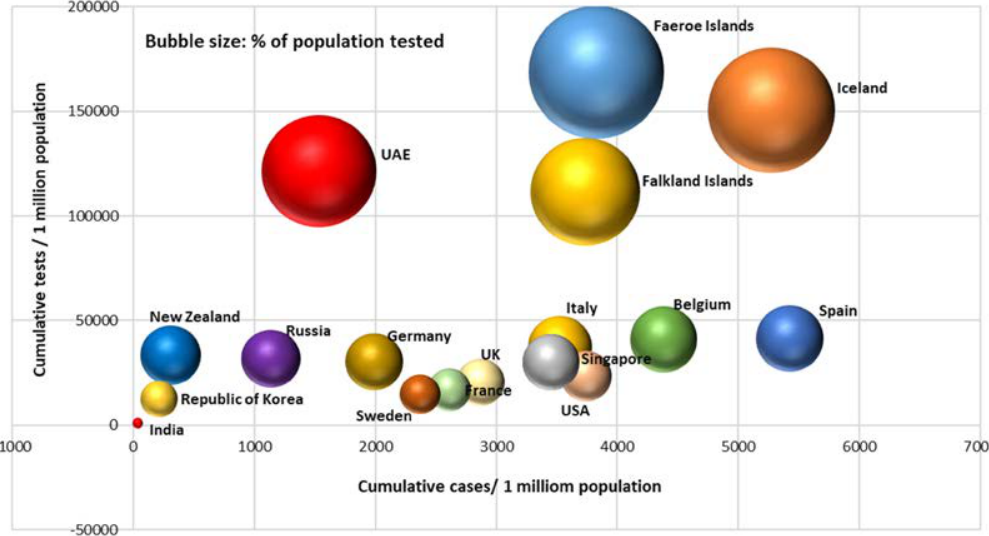
Fig. 4. Proportions of population tested for COVID-19 in different